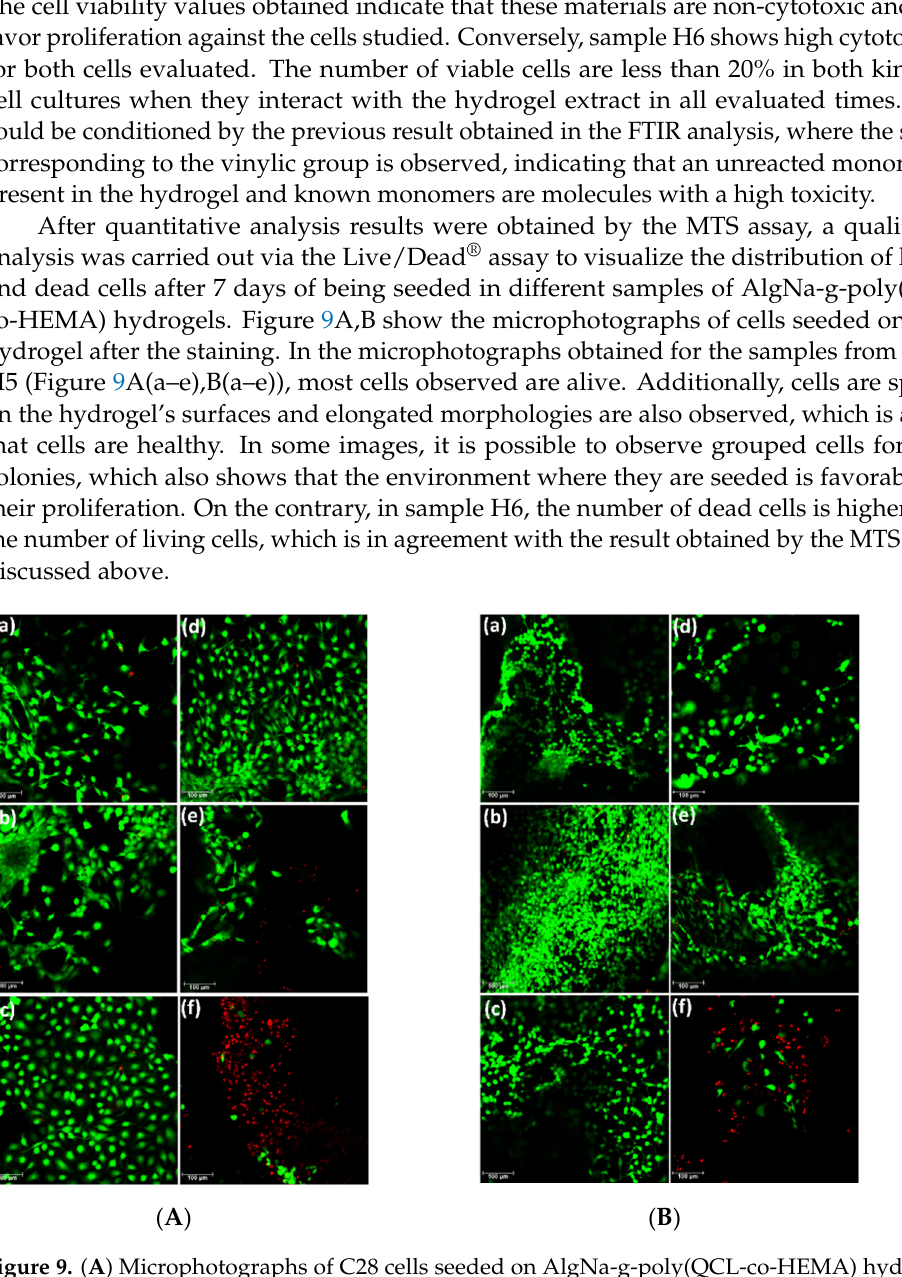
Figure 9. ( A ) Microphotographs of C28 cells seeded on AlgNa-g-poly(QCL-co-HEMA) hydrogels after 7 days, ( a ) H1, ( b ) H2, ( c ) H3, ( d ) H4, ( e ) H5, ( f ) H6. ( B ) Microphotographs of 3T3 cells seeded on AlgNa-g-poly(QCL-co-HEMA) hydrogels after 7 days, ( a ) H1, ( b ) H2, ( c ) H3, ( d ) H4, ( e ) H5, ( f ) H6.